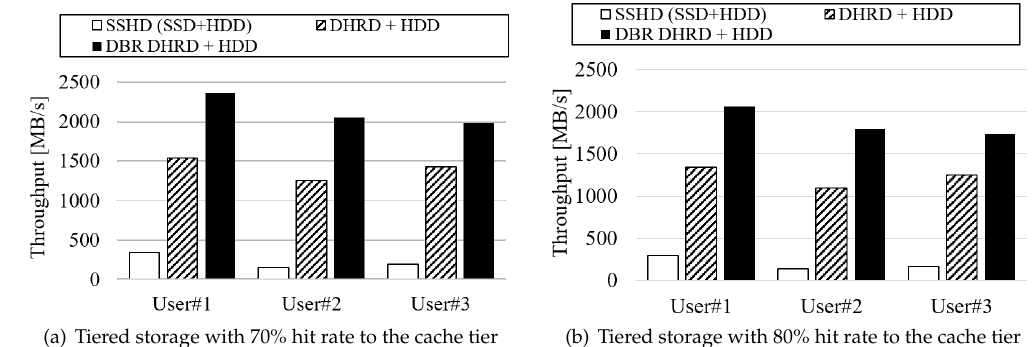
Figure 11. The results of tiered storage in hybrid storage device. It plots I/O throughputs of tiered storage assuming that SSD, DHRD, and DBR DHRD are used as a cache tiered in a tiered storage.